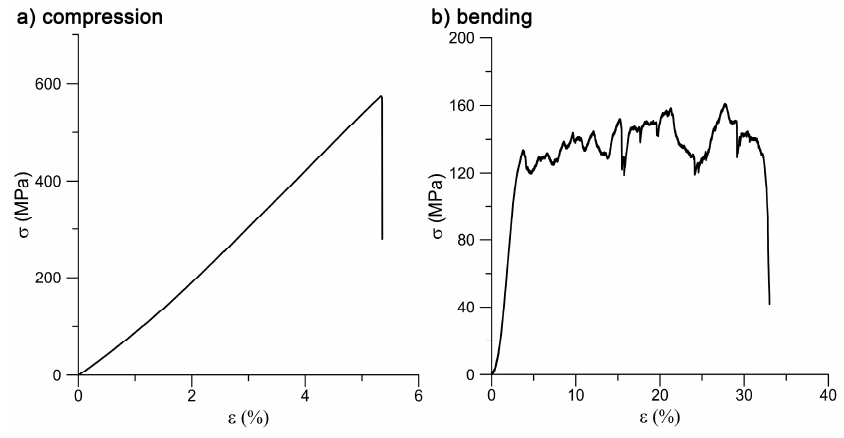
Figure 6. Compressive and bending stress-strain curves . Table 1 . Mechanical properties (UCS = ultimate compressive strength, BS = bending strength, E = Young ′ s modulus).